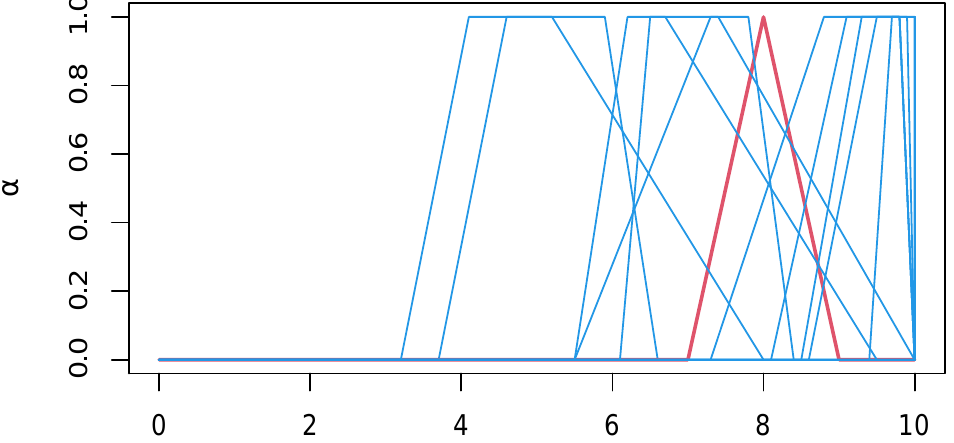
Figure 5. Fuzzy rating scale-based data from the 13 experts on Item 1 in blue and the comparison FN, C , in red.